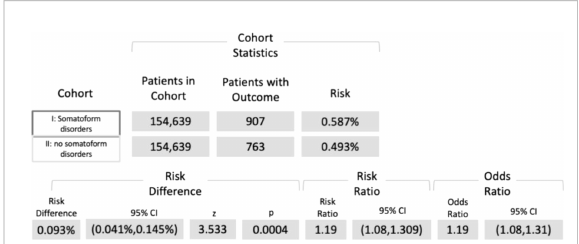
FIGURE 2 Five-year risk of developing OSCC among patients diagnosed with ICD-10 codes F45.8, and/or F59, and/or G47.63, and/or G47.8 (cohort I) compared with individuals without the respective disturbances (cohort II). ICD-10 code F45.8 = “ somatoform disorders including psychogenic disturbances ” (e.g., bruxism